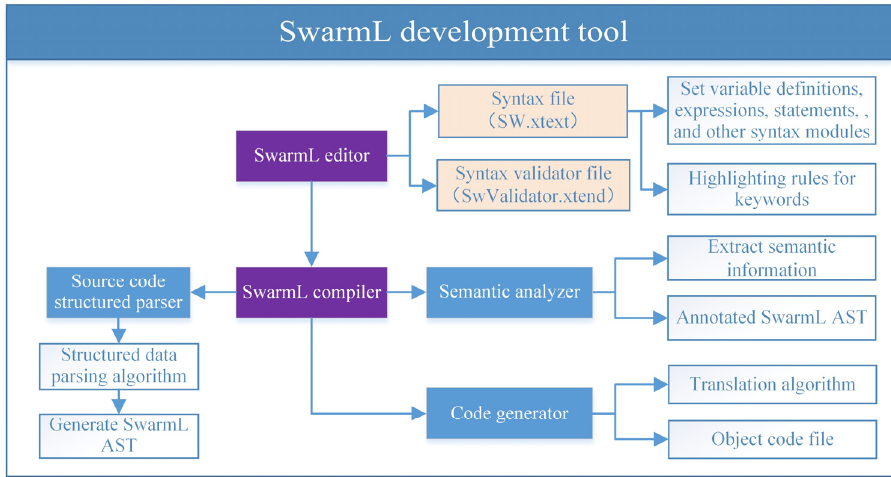
Figure 11. The basic architecture of SwDET.